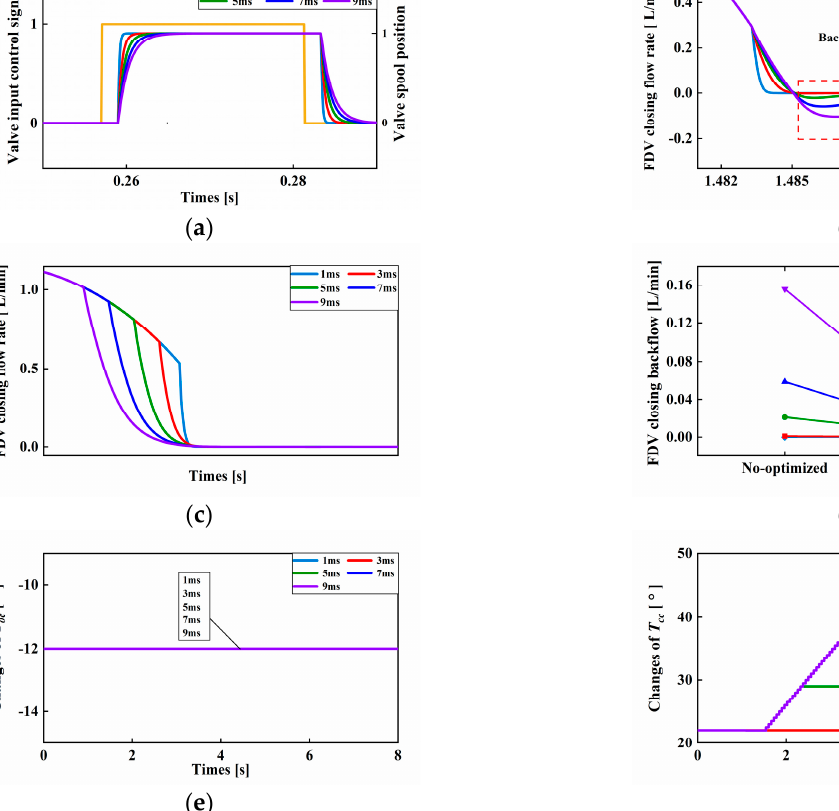
Figure 11. The results of different dynamic characteristics of FDV: ( a ) spool displacement; ( b ) flow rate before optimization; ( c ) optimized flow rate; ( d ) comparison backflow of FDV closing process; ( e ) T oc curve; ( f ) T cc